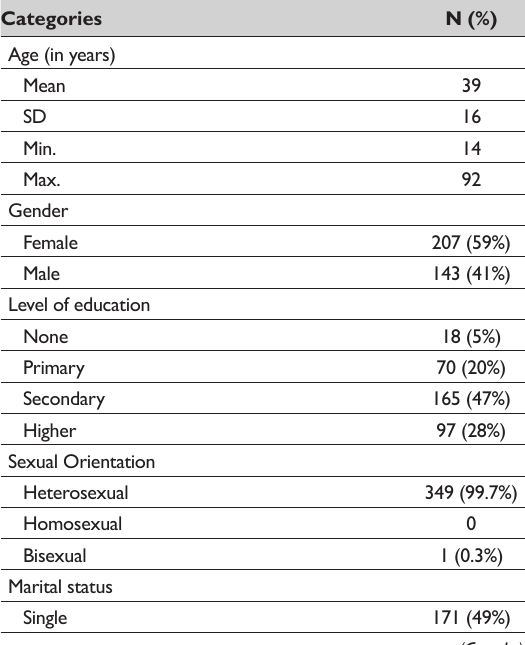
Table 1: General characteristics of study